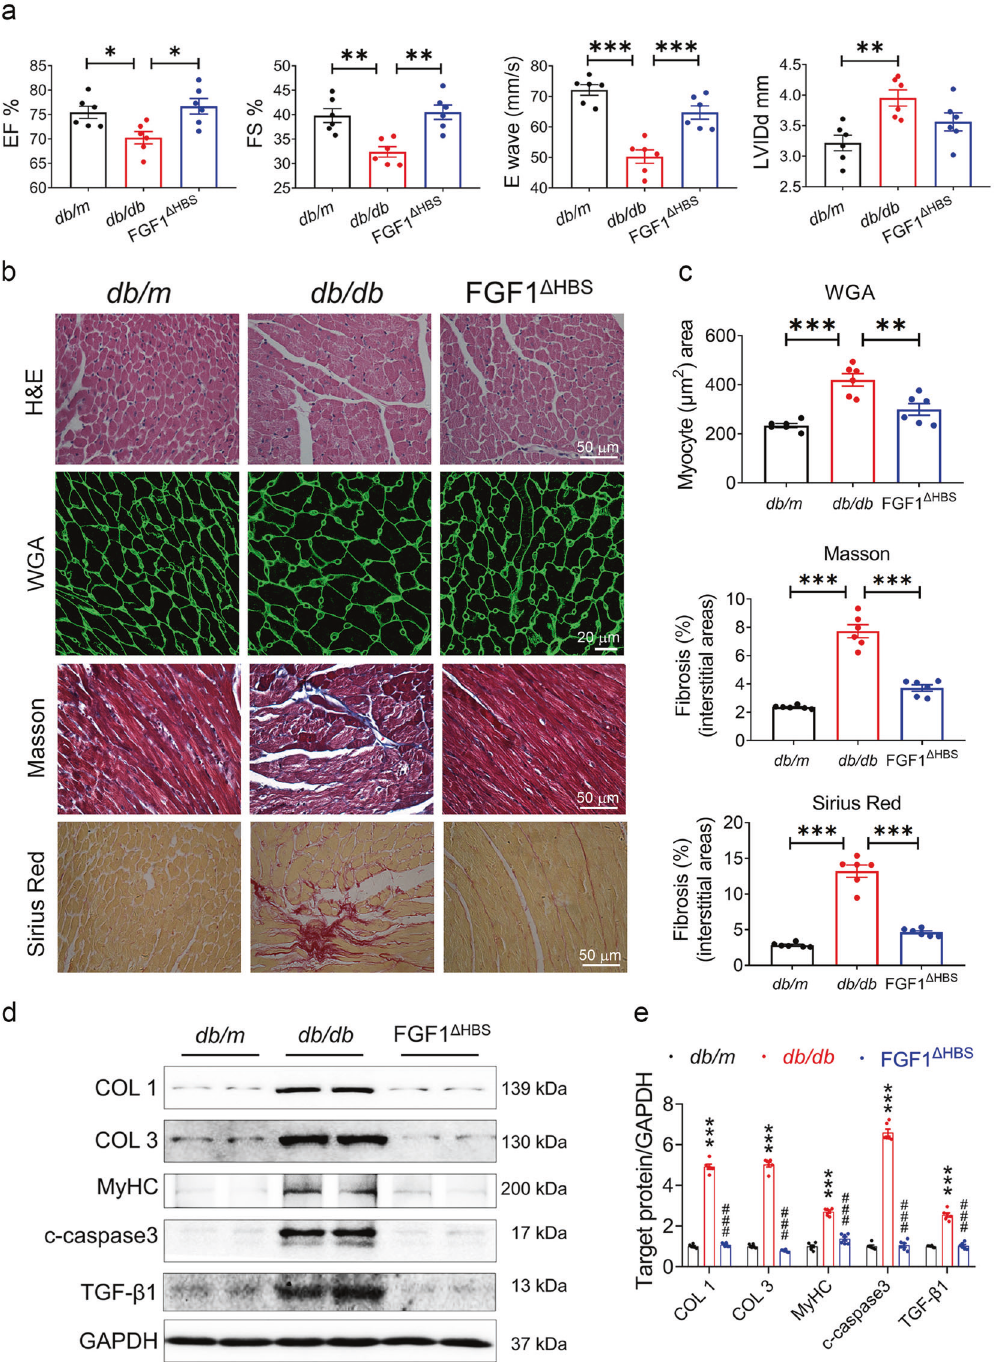
Fig. 2 FGF1 Δ HBS prevents cardiac dysfunction and remodeling in db/db mice. a – e db/db mice were treated with FGF1 Δ HBS (0.5 mg/kg body weight) or vehicle every other day for 16 weeks, and littermate db/m mice served as controls. a Echocardiographic parameters. n = 6. b Representative images of hematoxylin-eosin (H&E), WGA, Masson ’ s trichrome, Sirius red staining in cardiac tissues. c Quanti fi cation of myocyte area and cardiac fi brosis area in WGA, Masson ’ s trichrome and Sirius Red staining. n = 6. d Western blot analysis of collagen I (COL 1), collagen III (COL 3), myosin heavy chain (MyHC), cleaved caspase 3 (c-caspase 3) and transforming growth factor β 1 (TGF- β 1) in cardiac tissues; GAPDH was a loading control. e Densitometric quanti fi cation of western blots shown in d . n = 6. Data were mean ± SEM; * P < 0.05, ** P < 0.01, *** P < 0.001 in a , c ; *** P < 0.001 vs. db/m , ### P < 0.001 vs. db/db in